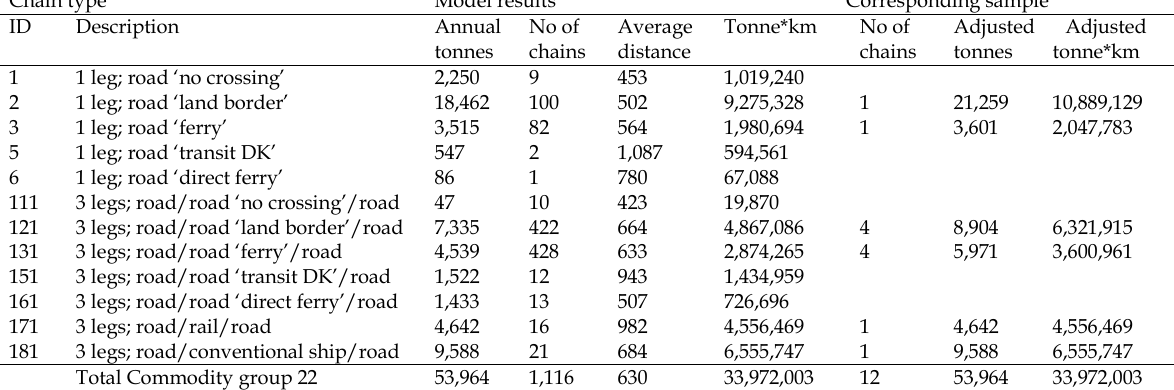
Table 2. Sample design for Commodity group 22 (fertilizers) Chain